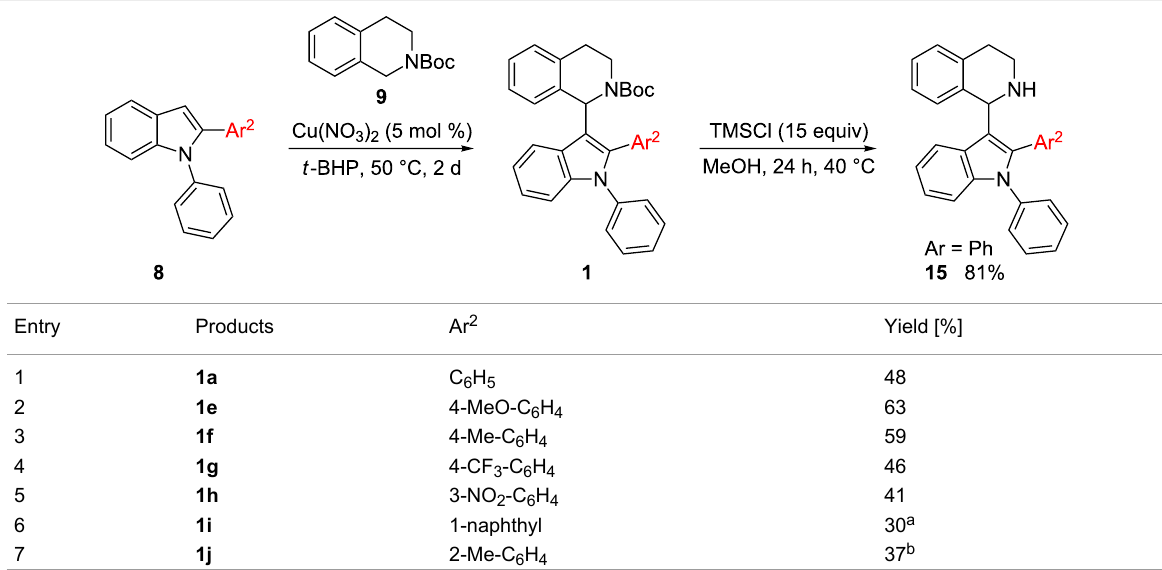
Table 9: Substrate scope for reactions of 1,2-diarylindoles 8 with N -Boc-THIQ 9